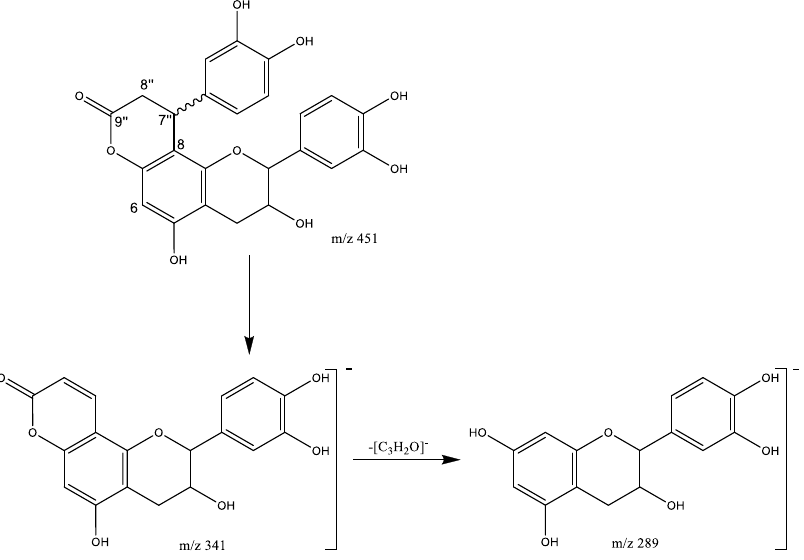
Figure 11. Cinchonains fragmentation pathway. Table 1. Profile of proanthocyanidins and flavalignans identified by UPLC-QTOF-ESI MS analysis of U. tomentosa leaves.